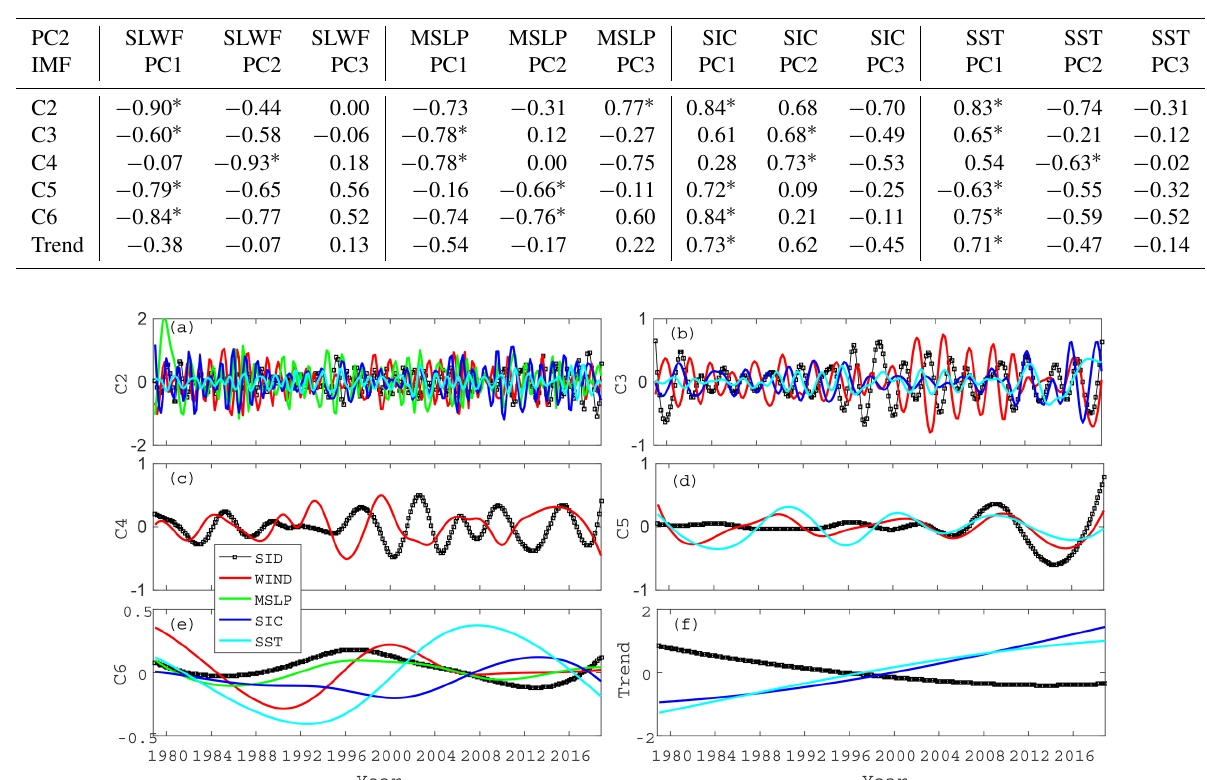
nificant correlation with atmospheric environmental